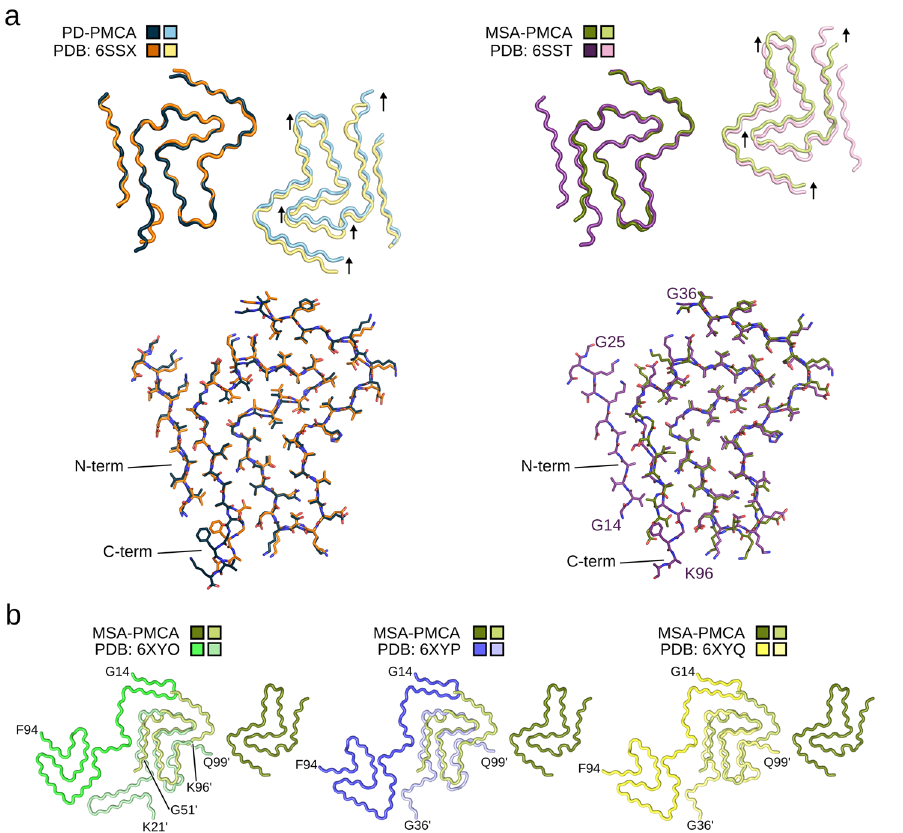
Fig. 3 Ampli fi ed α Syn fi brils reveal a common proto fi lament fold. a Overlay of the PD-PMCA and the MSA-PMCA α Syn fi bril structures onto two opposite subunits of recombinant in vitro aggregated α Syn fi brils with PDB IDs 6SSX (termed “ polymorph 2A ” ) and 6SST (termed “ polymorph 2B ” ) 20 , respectively. Arrows mark relative shifts between the in vitro α Syn fi brils and the PD/MSA-PMCA α Syn fi brils (displayed in light colors) after superimposing the C α atoms of the opposite subunits (displayed in dark colors). Below, the superposition of single proto fi laments is shown, highlighting changes in the C-terminal structure. b Overlay of the MSA-PMCA α Syn fi bril structure determined in the current study (labeled “ from MSA ” ) onto structures determined for α Syn fi brils extracted from the brains of individuals with MSA. The ex vivo MSA fi bril structures (PDB IDs 6XYO, 6XYP, and 6XYQ) 13 are colored in shades of green, blue, and yellow, respectively, with amino acids from subunit B labeled with an additional